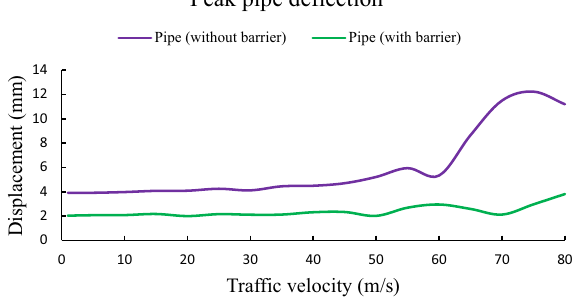
Figure 8. Influence of traffic speed on peak pipe